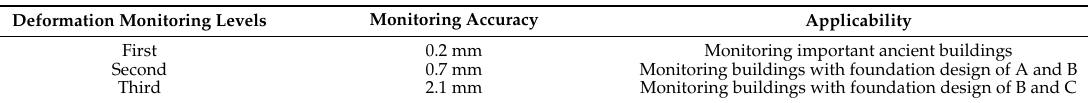
Table 1. Monitoring levels and accuracy of